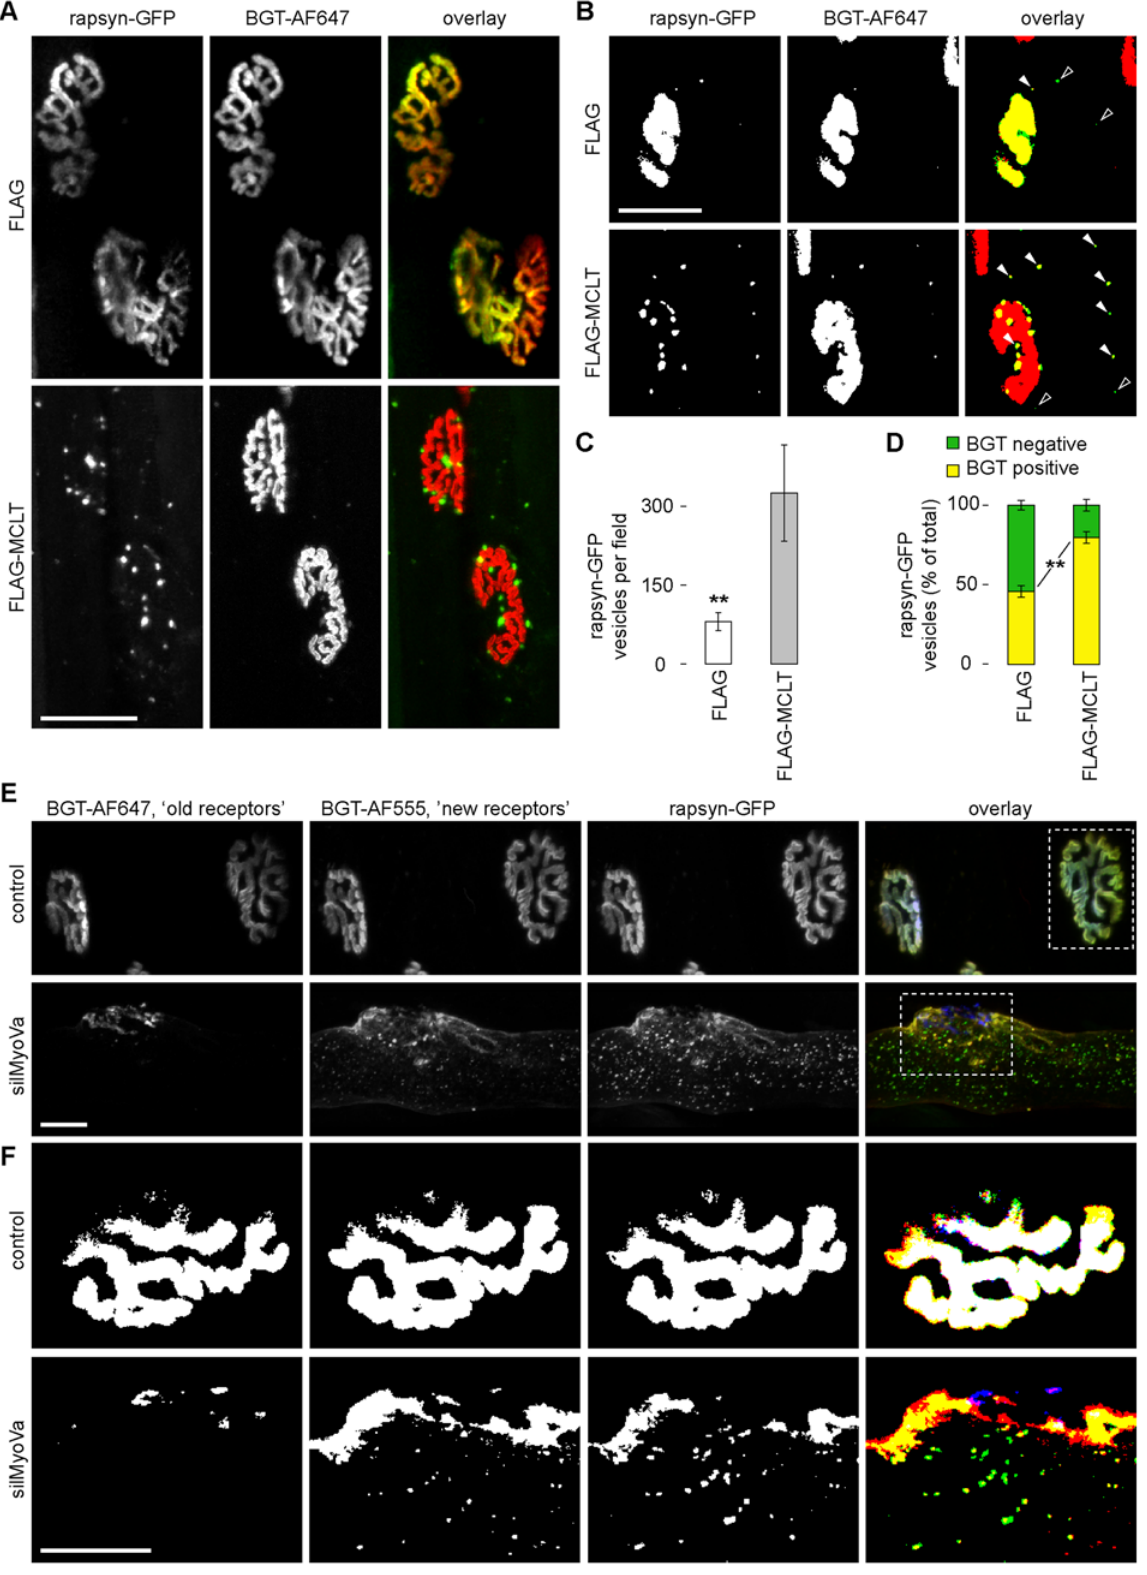
Figure 7. Amount of rapsyn-GFP positive punctate structures and their co-localisation with BGT-AF647 are increased in FLAG-MCLT or silMyoVa transfected muscles in vivo. TA muscles of adult wildtype mice were either transfected with rapsyn-GFP (E–F) or co-transfected with rapsyn-GFP and FLAG (A–D), FLAG-MCLT (A–D) or silMyoVa (E–F). Muscles in E–F were also injected with BGT-AF647 during transfection. Ten days